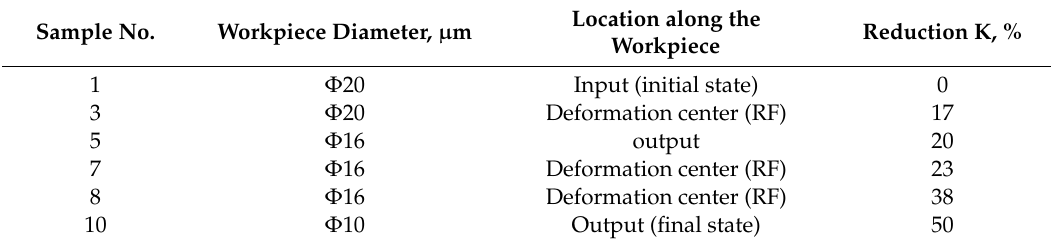
Table 3. Tested samples according Figure